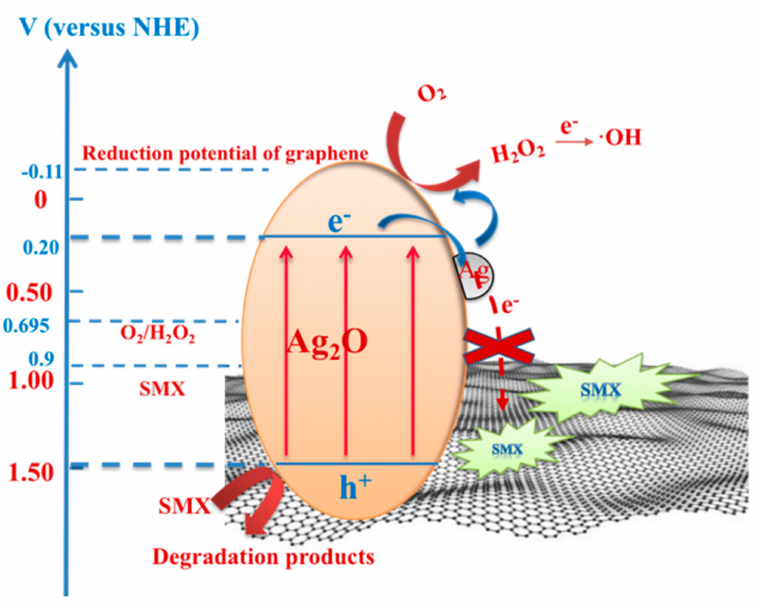
Figure 8. The charge separation and transfer in SMX photodegradation over the Ag@Ag 2 O-G catalysts under visible